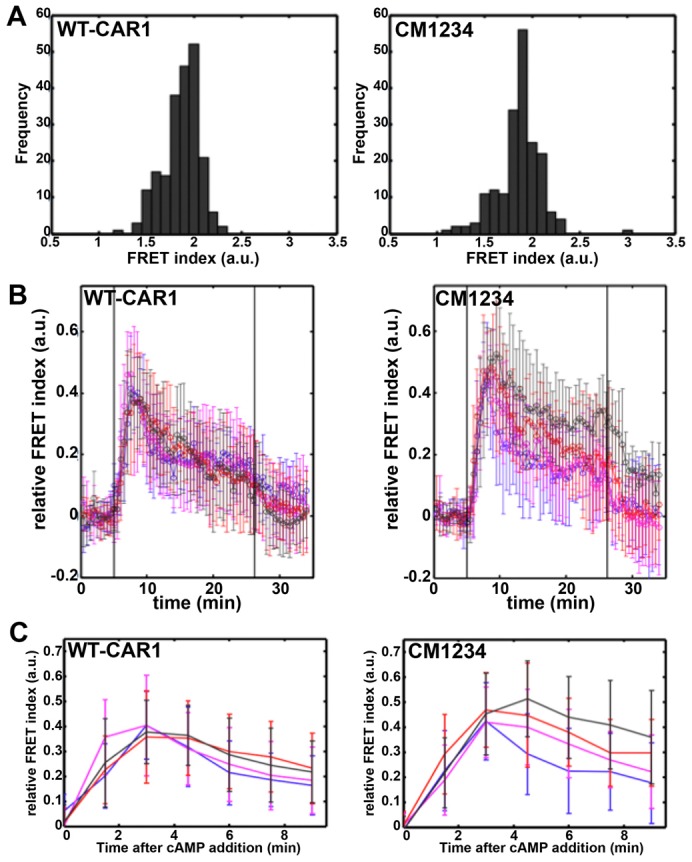
Live-cell imaging of intracellular cAMP suggests defective adaptation of ACA in CM1234 cells. (A) Histograms are shown for non-stimulated FRET ratios (a.u. = arbitrary units) as a function of numbers of WT-CAR1 and CM1234 cells (frequency) that express the cAMP sensor Epac1-camps. The time averages during the first 5 minutes prior to stimulation were obtained from each single-cell time series. The averages are 1.86±0.19 (s.d.) for WT-CAR1 cells and 1.86±0.23 (s.d.) for CM1234 cells and correspond to ∼400 nM basal cAMP for each cell type. (B) WT-CAR1 or CM1234 cells were stimulated with a constant cAMP concentration in a perfusion chamber using a pair of syringe pumps. The flow rate was kept constant at 2 ml/minute. Cells attached to a glass surface were first exposed to buffer without cAMP. Time-lapse recording (t = 0 minute) was started after 5–7 minutes. After an additional 5 minutes of plain buffer flow, the pump source was switched to buffer containing cAMP (black vertical line at t = 5 minutes) at 1 nM (blue), 10 nM (magenta), 100 nM (red) and 1 µM (black). The input flow was switched back to plain buffer after 25 minutes; the second black vertical line indicates the time (t∼27 minutes) when the concentration of exogenous cAMP had decreased by a factor of 1/e. The time-plots are relative FRET averages (a.u. = arbitrary units) from more than eight cells for each condition. Error bars indicate s.d. at each time point. (C) Data from Fig. 5B were time-binned at 1.5 minutes intervals. cAMP doses were at 1 nM (blue), 10 nM (magenta), 100 nM (red) and 1 µM (black). Error bars indicate s.d. at each time point.